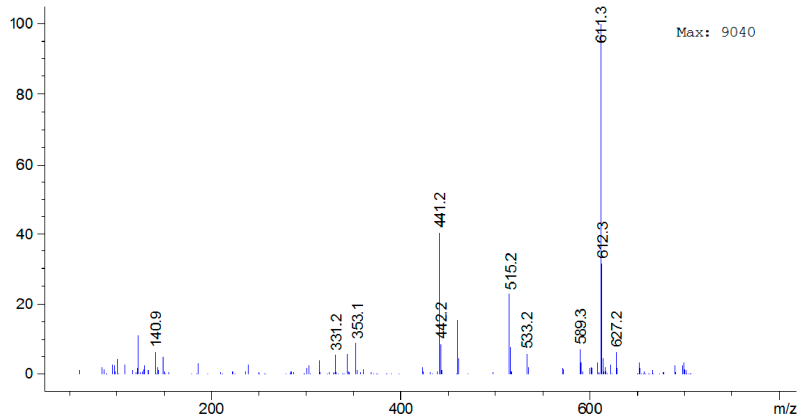
Figure 5. Mass spectrum of propionylbrassinolide recorded in the positive mode.